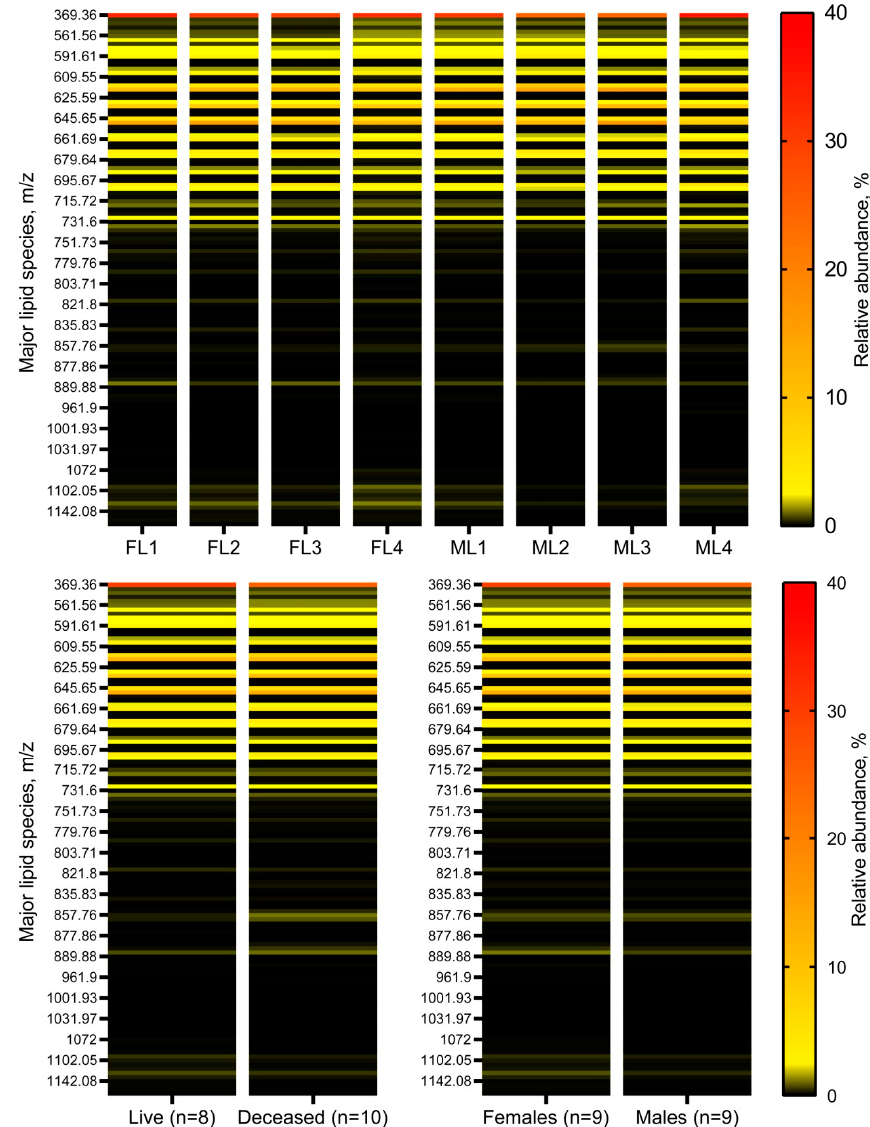
Figure 3. Targeted lipidomic analysis of female and male meibum specimens revealed no major gender-related differences in their chemical composition. ( Upper panel ) Heat maps of meibomian lipids observed in representative female (FL1–FL4) and male (ML1–ML4) samples. Note that due to space constraints only some of the 125 analyzed major lipids are labeled. ( Left lower panel ) Heat maps of averaged meibum samples of live ( n = 8) and deceased ( n = 10) donors. No major differences were observed except for somewhat increased levels of normal triacylglycerols (such as those with m/z values of 857.76, 859.77 and others) in the deceased group of samples. ( Right lower panel ) Heat maps of averaged meibum samples of female ( n = 9) and male ( n = 9) donors. No major differences were noted, with the exception of a slightly elevated (by ~18%) total CEs-to-total WEs ratio and apparently random changes in all groups of lipids.